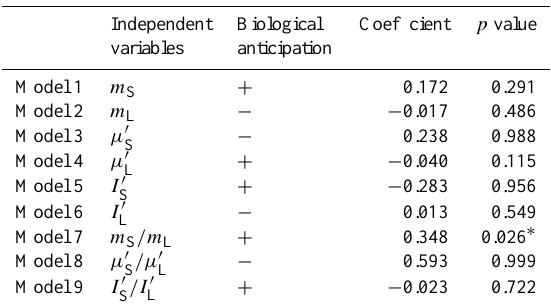
Table 2. Results of univariate correlation analysis examining the re- lationship between NBSS slopes versus size-specific growth rates, mortality, grazing impacts, and the ratio of small versus large size category for these variables. The subscript (S or L) indicates the size category (small or large). µ 0 represents size-specific growth rates measured without nutrient amendment; m represents size-specific grazing mortality; I 0 represents grazing impact measured without nutrient amendment ( I 0 = m/µ 0 ). Biological anticipations represent the expected positive ( + ) or negative ( − ) relationship between each variable versus size spectral slopes, according to biological reason- ing. The effect (coefficient) of each independent variable on NBSS slopes was tested against the biological anticipation using one-tail tests.